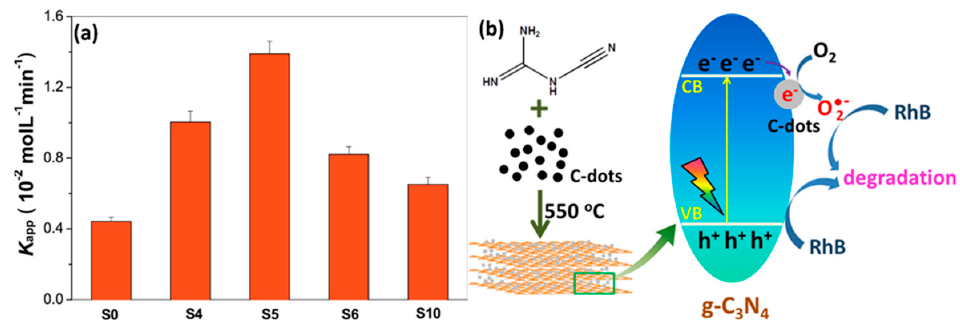
Figure 5. ( a ) Comparison of the degradation rate constant of C-dots-modified g-C 3 N 4 ( b ) Schematic diagram showing the one-pot synthesis of C-dots-modified g-C 3 N 4 with enhanced photocatalytic activity. Reproduced with permission from Elsevier [113].